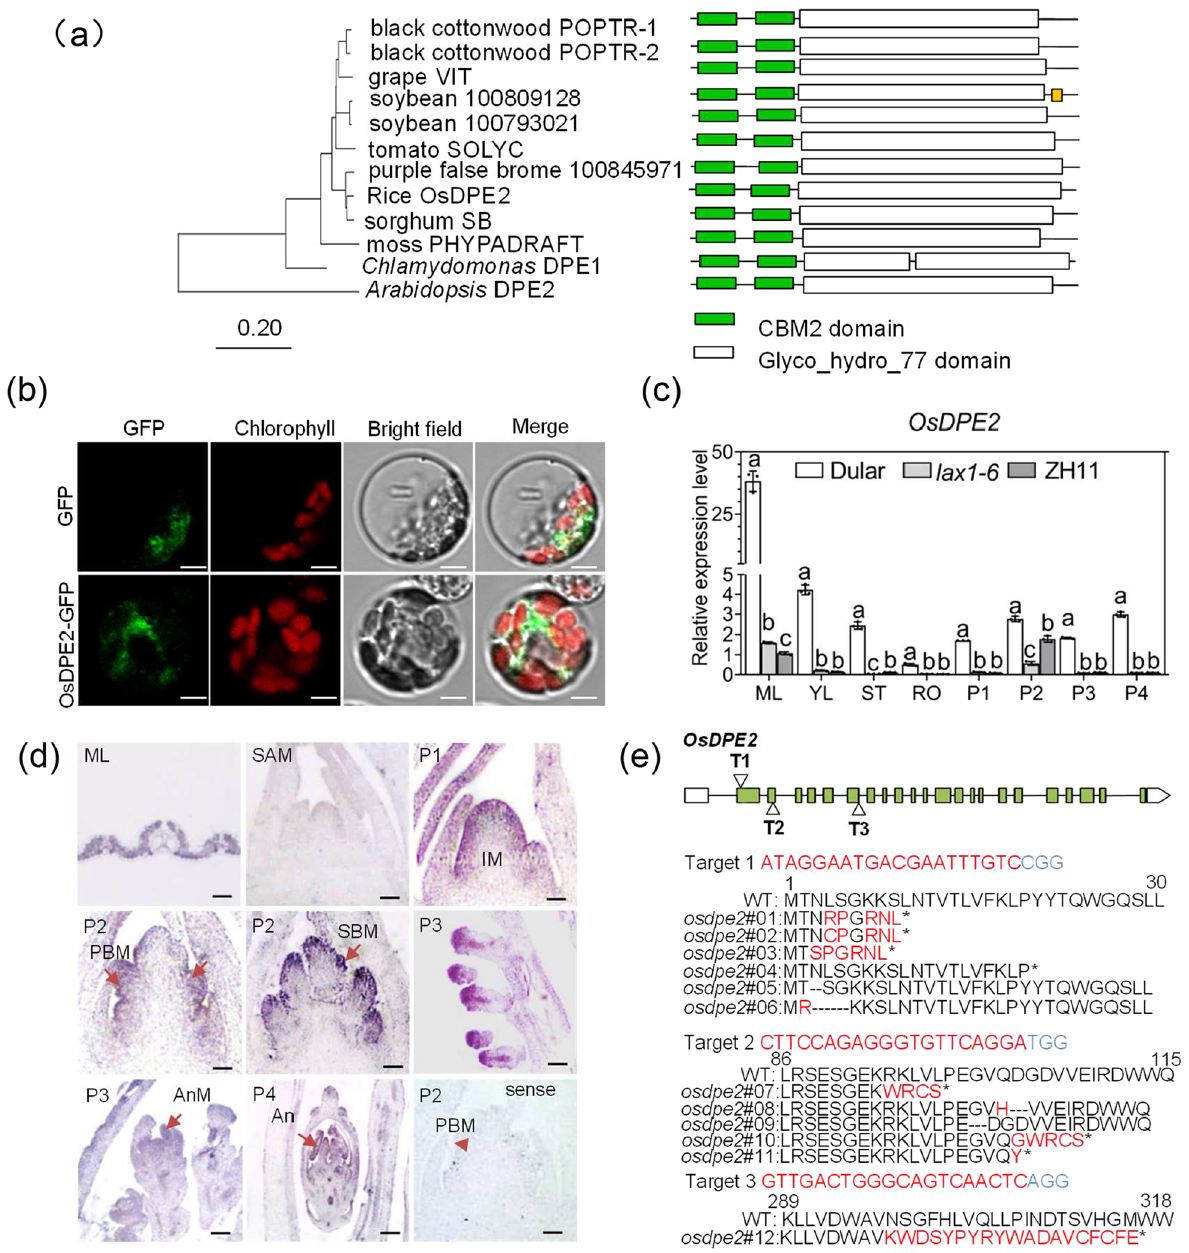
Fig. 2 OsDPE2 encodes rice Disproportionating Enzyme 2 located in the cytoplasm. a Phylogenetic analyses of DPE2 protein sequences from rice, Arabidopsis , soybean, tomato, sorghum, black cottonwood, grapes, purple false brome, moss, and Chlamydomonas . b Subcellular localization analysis of OsDPE2 in rice. OsDPE2-GFP and control GFP were transiently transformed into rice protoplasts. OsDPE2-GFP fluorescence signal was mainly detected in cytoplasm. Scale bar 5 μm. c RT-qPCR showing the expression pattern of OsDPE2 in the mature young leaf (YL), stem (ST), root = (RO), and in several developmental stages of young panicles (1 mm (P1), 2 mm (P2), 3–5 mm (P3), and > 10 mm (P4) young panicles) in ZH11, lax1-6 and Dular; Tukey’s multiple comparisons test. Different letters represent statistically significant differences between data groups. d OsDPE2 -specific antisense chain probes used for in situ hybridization of the paraffin sections of leaves and young panicles at various stages of ZH11 background samples. SAM secondary apical meristem, IM inflorescence meristem, PBM primary branch meristem, SBM secondary branch meristem, SM spikelet meristem, AnM anther meristem, An anther, T tapetum. Scale bar 50 μm. e Twelve allelic mutants from transgenic ZH11 plants. osdpe2#01 was = used for subsequent functional analysis in